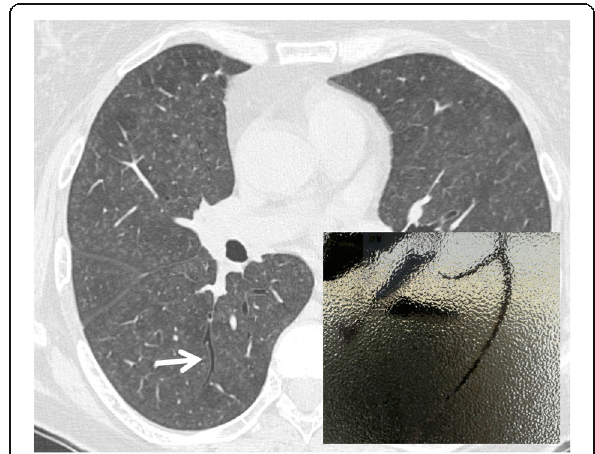
Fig. 8 Dark bronchus sign. The figure shows a patent bronchial structure (white arrow) — which appears slightly dark — in the context of lung parenchyma area with a ground glass appearance. The dark bronchus sign is very useful to recognize pulmonary infection by Pneumocystis jirovecii